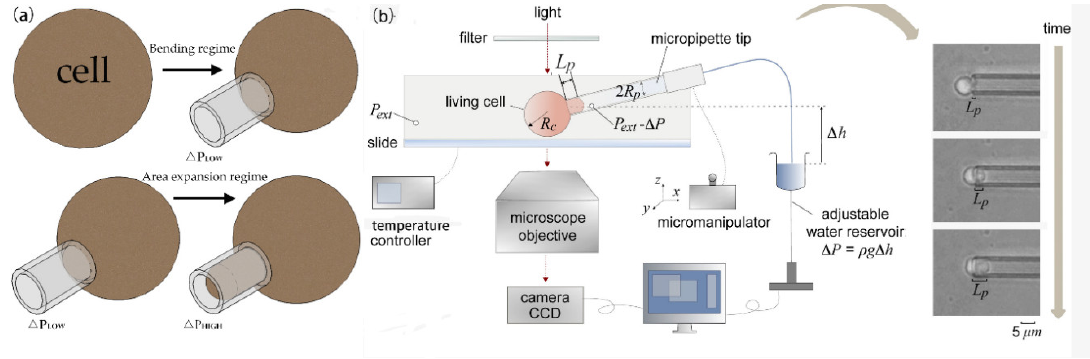
Figure 2. ( a ) Micropipette aspiration schematic diagram. ( b ) Experimental scheme and images of micropipette aspiration. (Adapted by kind permission from [65]).